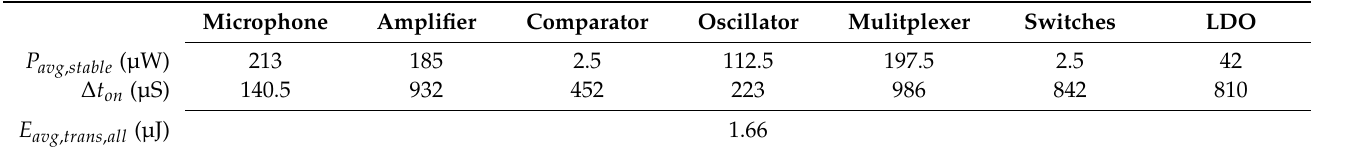
Table 2. Overview of the measured power consumption per component and their wake-up time. Precision current measurements were performed at a reference voltage fixed at